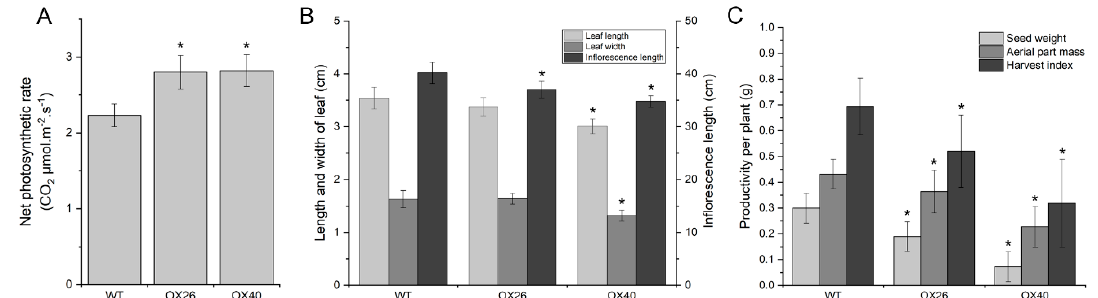
Figure 6. Growth and productivity alteration of the wild-type plants and two GmGATA58 overexpression transgenic lines of Arabidopsis thaliana . The net photosynthetic rate ( A ), growth vigor ( B ) and productivity per plant ( C ) were measured in the wild-type (WT) plant and two overexpression lines OX26 and OX40. Data are presented as mean ± SD bar, and asterisks (*) indicate significant differences against the WT plant at the level of p < 0.05.